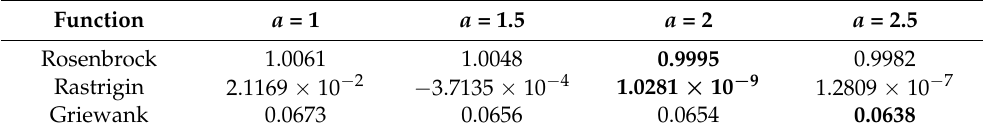
Table 2. Mean optimal function value of three criterion functions with different values of parameter a